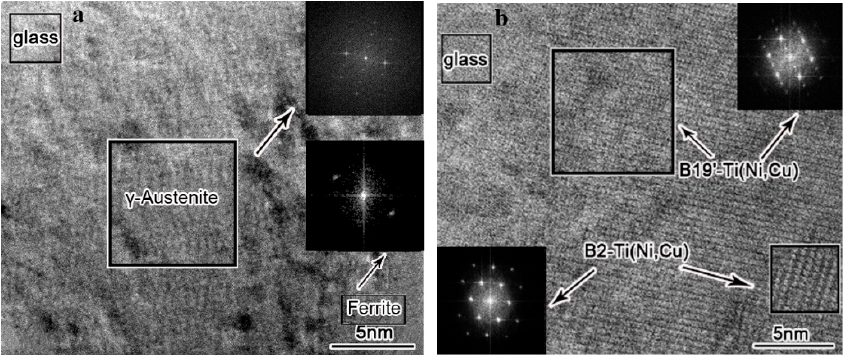
Figure 1. High-resolution transmission electron microscopy (HRTEM) and fast Fourier transform (FFT) of ( a ) the as-cast Fe 65.4 Mn 14.3 Si 9.4 Cr 10 C 0.9 and ( b ) Ti 40 Ni 40 Cu 20